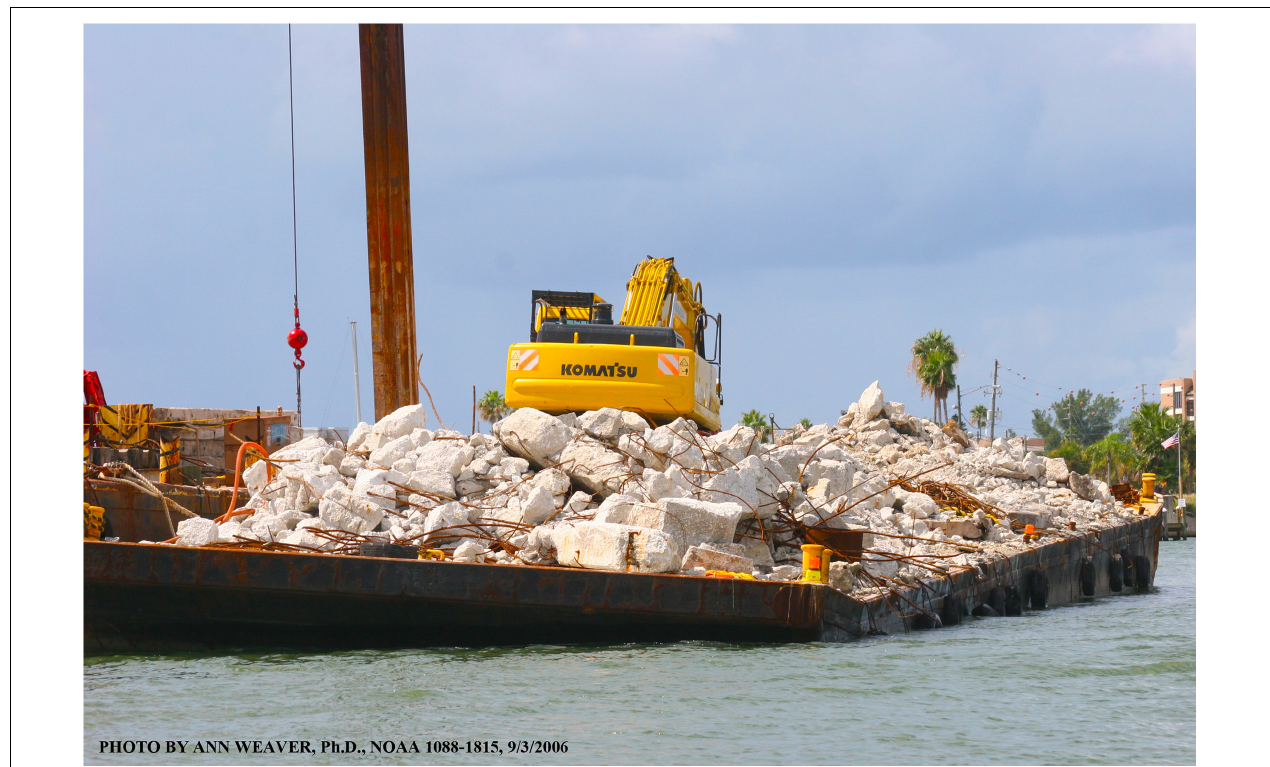
FIGURE 7 | Barges were regularly loaded with rubble, ranging in size from peas to cars, from old cement structures extracted from above and below seafloor. Rubble was transported to off-shore dump sites throughout construction.